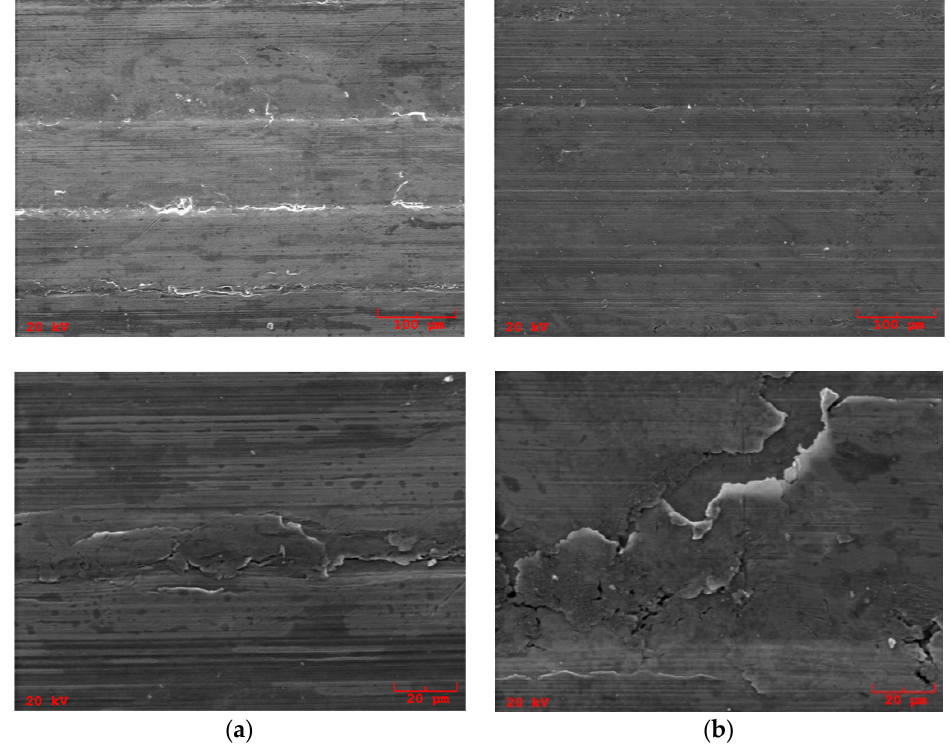
Figure 10. Micrographs of SAE-48 bearing after tests; ( a ) 15W-40 engine oil; ( b ) 5W-40 engine oil.